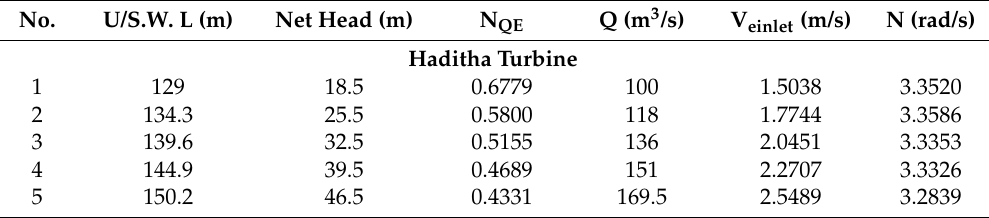
Table 4. Hydraulic data of the Haditha powerhouse turbine, including up-stream water levels (U/S.W. L), the flowrate (Q), the velocity (V), and the rotational speed of the turbine runner (N).